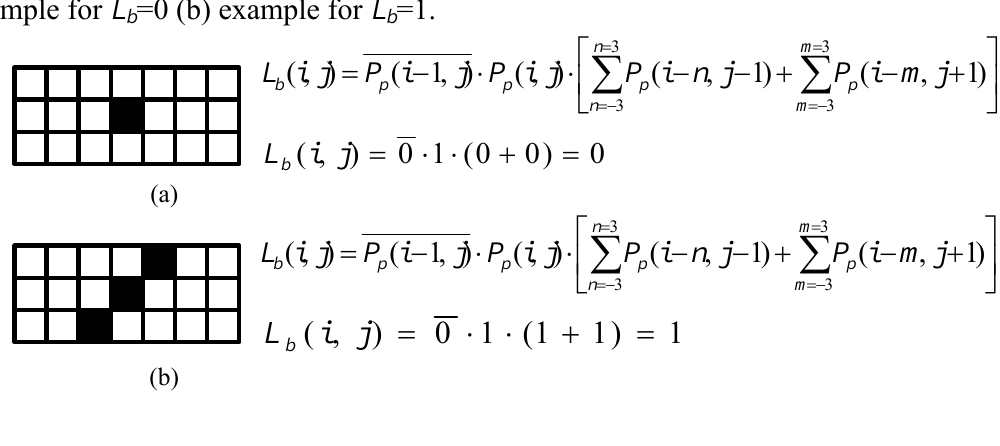
in Lane-Point Allocation Modules (a) b =1. b